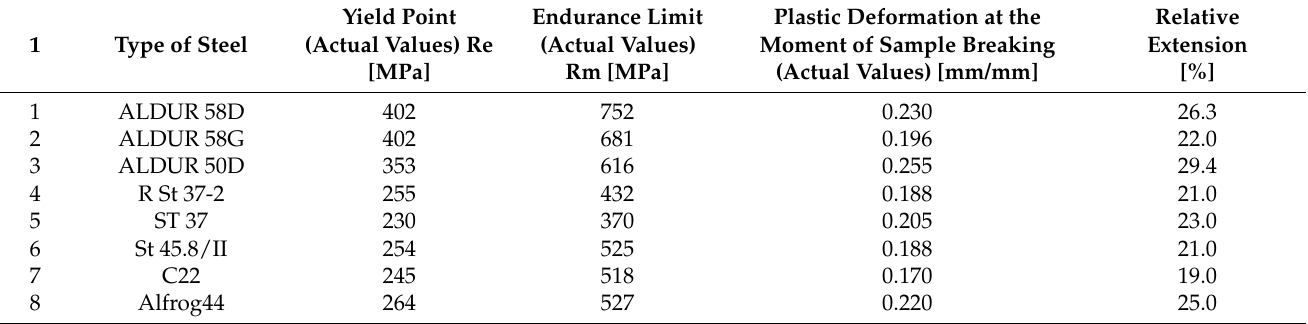
Table 1. Values of deformations and actual stresses of individual construction materials of tanks introduced into elastoplastic models taking into account the phenomenon of kinematic strengthening.